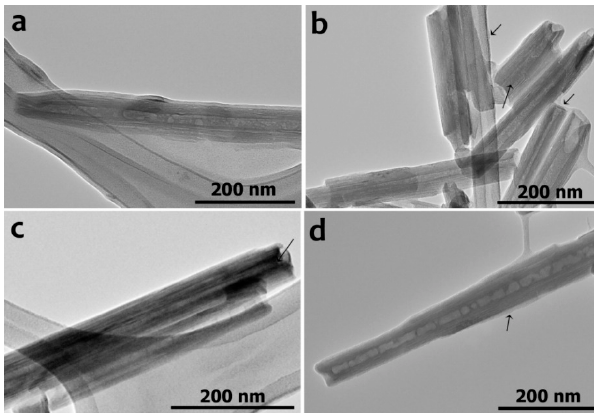
Figure 4. TEM images of halloysite nanotubes incubated with MgCl 2 ( a ), ATP-Mg ( b ), AMP and MgCl 2 ( c ), ultrasonicated DNA and MgCl 2 ( d ). (The presence of organic matter is indicated by